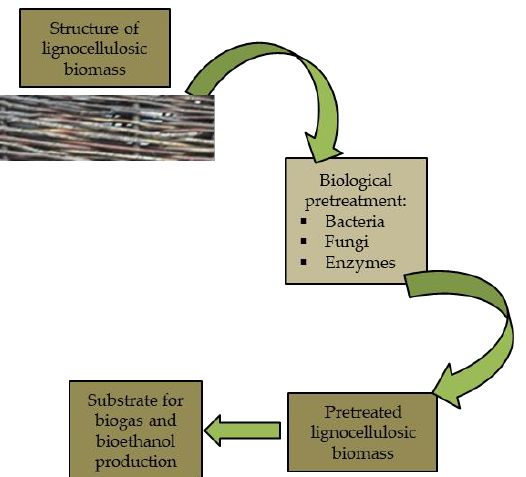
Figure 7. Biological pretreatment of LB for biogas and bioethanol production (modified from